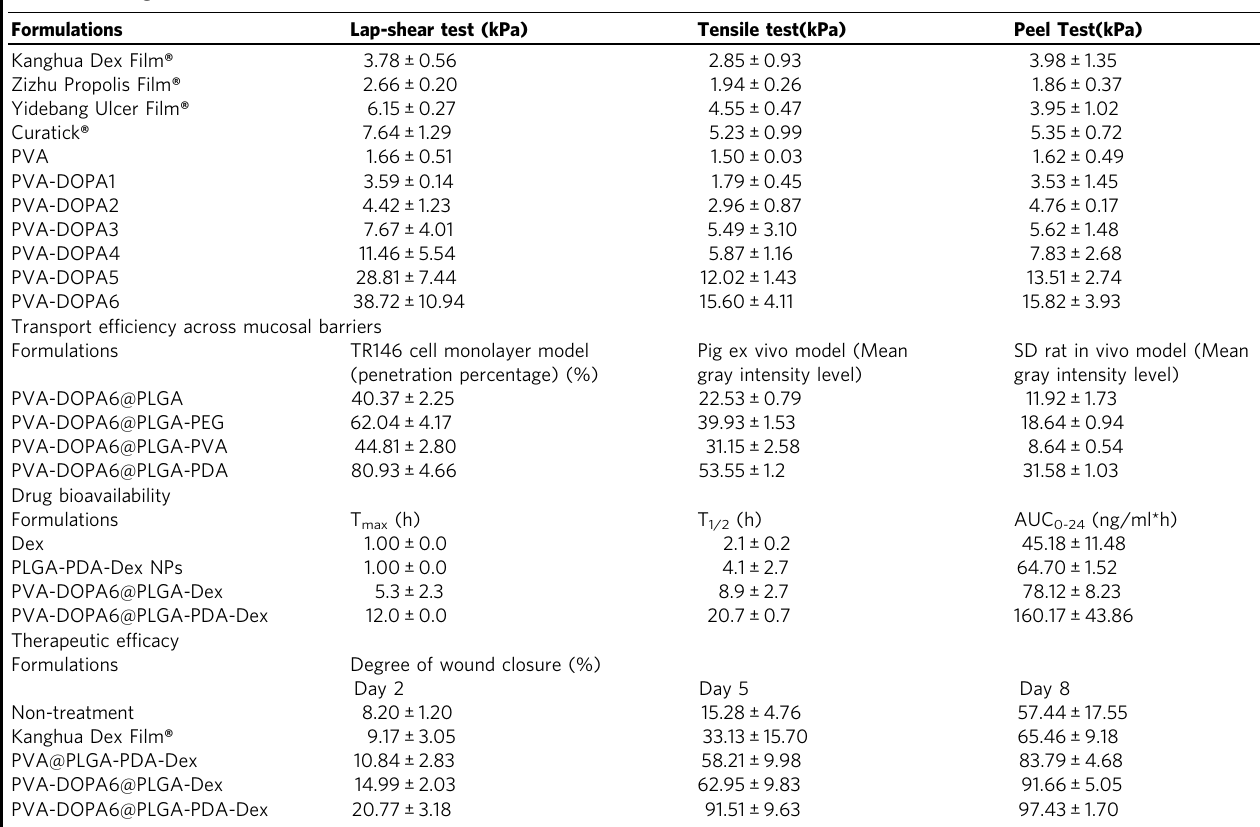
Table 1 Summary of mucoadhesion strength, transport ef fi ciency across mucosal barriers, drug bioavailability, and therapeutic ef fi cacy of mussel-inspired PVA-DOPA fi